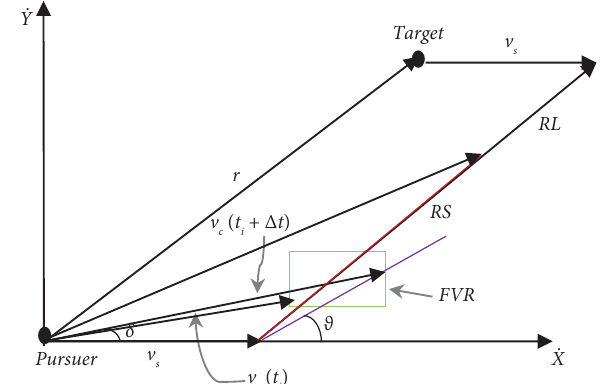
Figure 4: Construction of the velocity line.